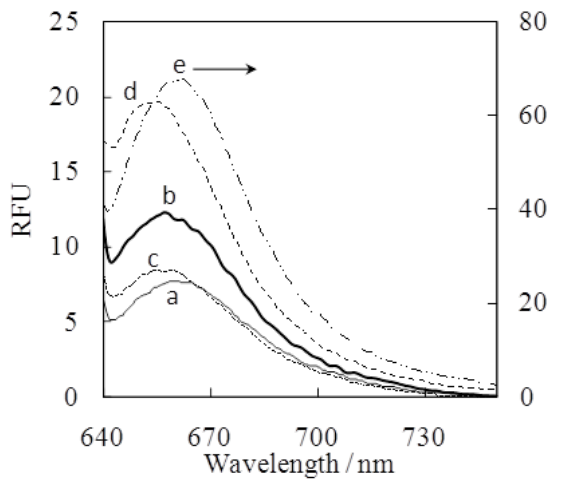
Figure 6. Emission spectra of SQ-BA (1.0  M) complexes with mucin type I–S and type III proteins in carbonate buffer (10 mM, pH 10.0): ( a ) blank; ( b ) [mucin type I–S] = 50 